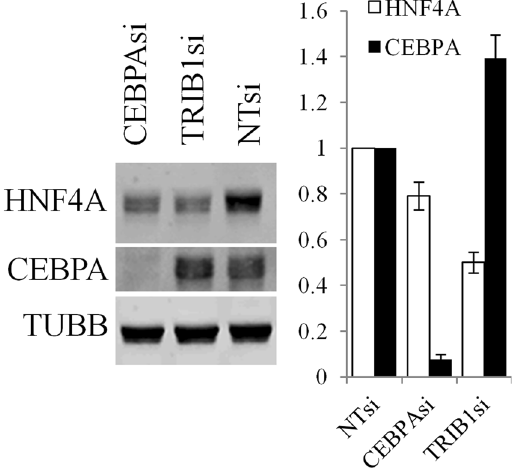
Figure 2. Interplay between TRIB1, CEPBA and HNF4A in HuH-7 cells. HuH-7 cells were silenced with the indicated siRNA for 48 h prior to Western blotting using the indicated antibodies. Representative blot is shown. Quantification of 3 Western blots is shown on the right; bars represent the means of 3 independent biological replicates ± S.D. All changes are statistically significant (p < 0.05) from